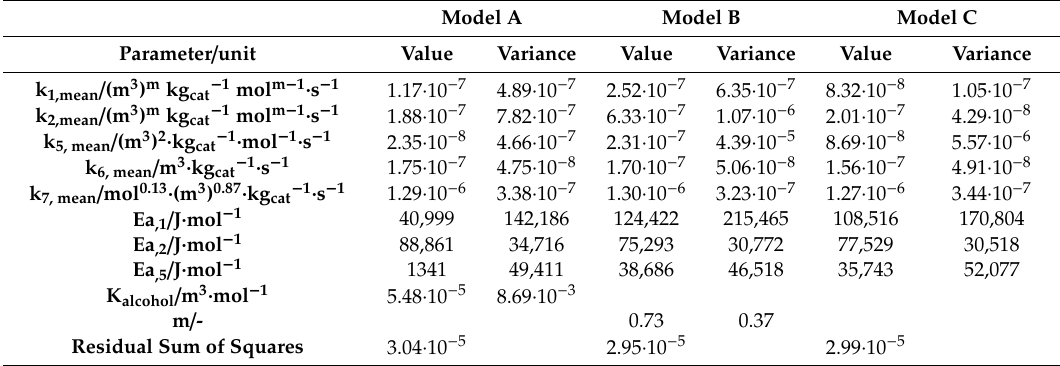
Table 1. Model parameter values estimated by Matlab, their variances and residual sums of squares for models A, B and